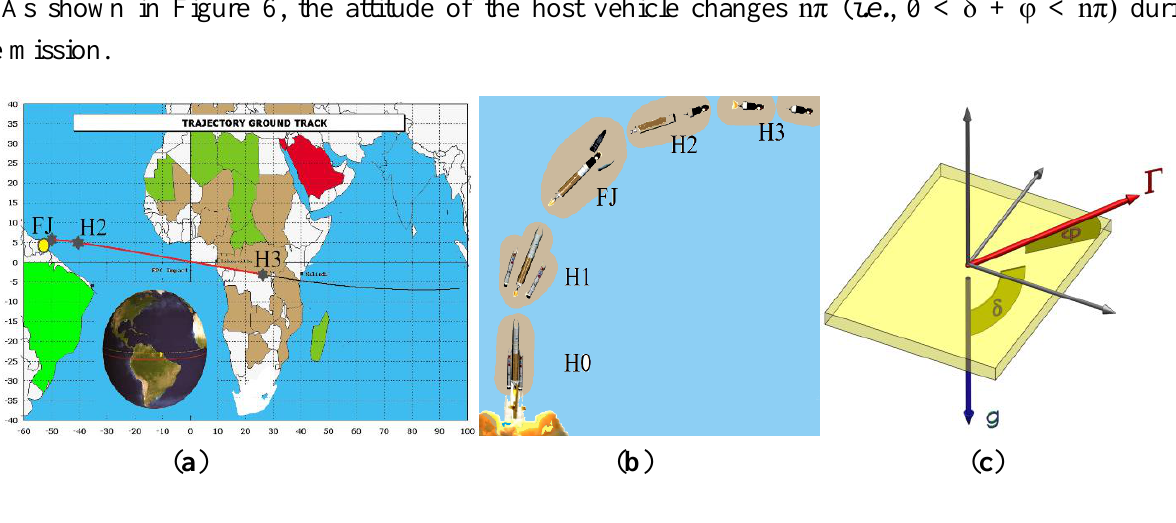
Figure 6. Crystal oscillator subjected to attitude and altitude changes of host vehicle. ( a ) Host vehicle trajectory ground track; ( b ) Attitude and altitude of host vehicle; Adapted from [7]. ( c ) Orientation of g, Γ and time variant angle δ on